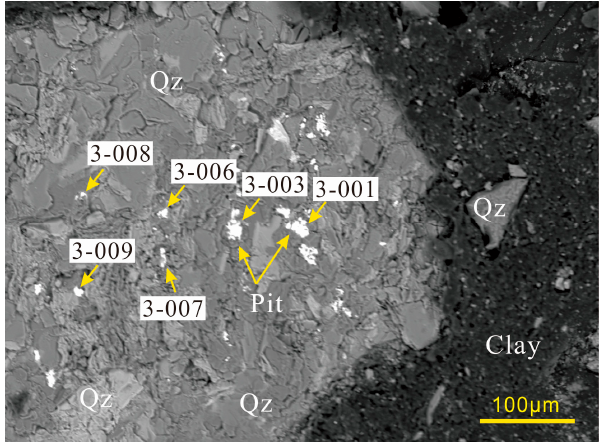
Figure 2. The backscattered electronic photograph of the uranium ore sample. Qz: quartz; Pit: pitchblende. The U oxide content results of the examined mixed ore sample (TCS-04) and of the ore